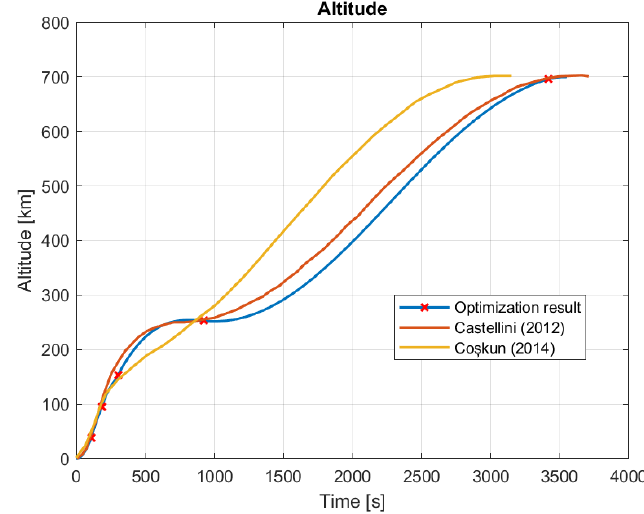
Figure 5. Altitude in the optimized trajectory. The red marks indicate the staging or coasting phase.